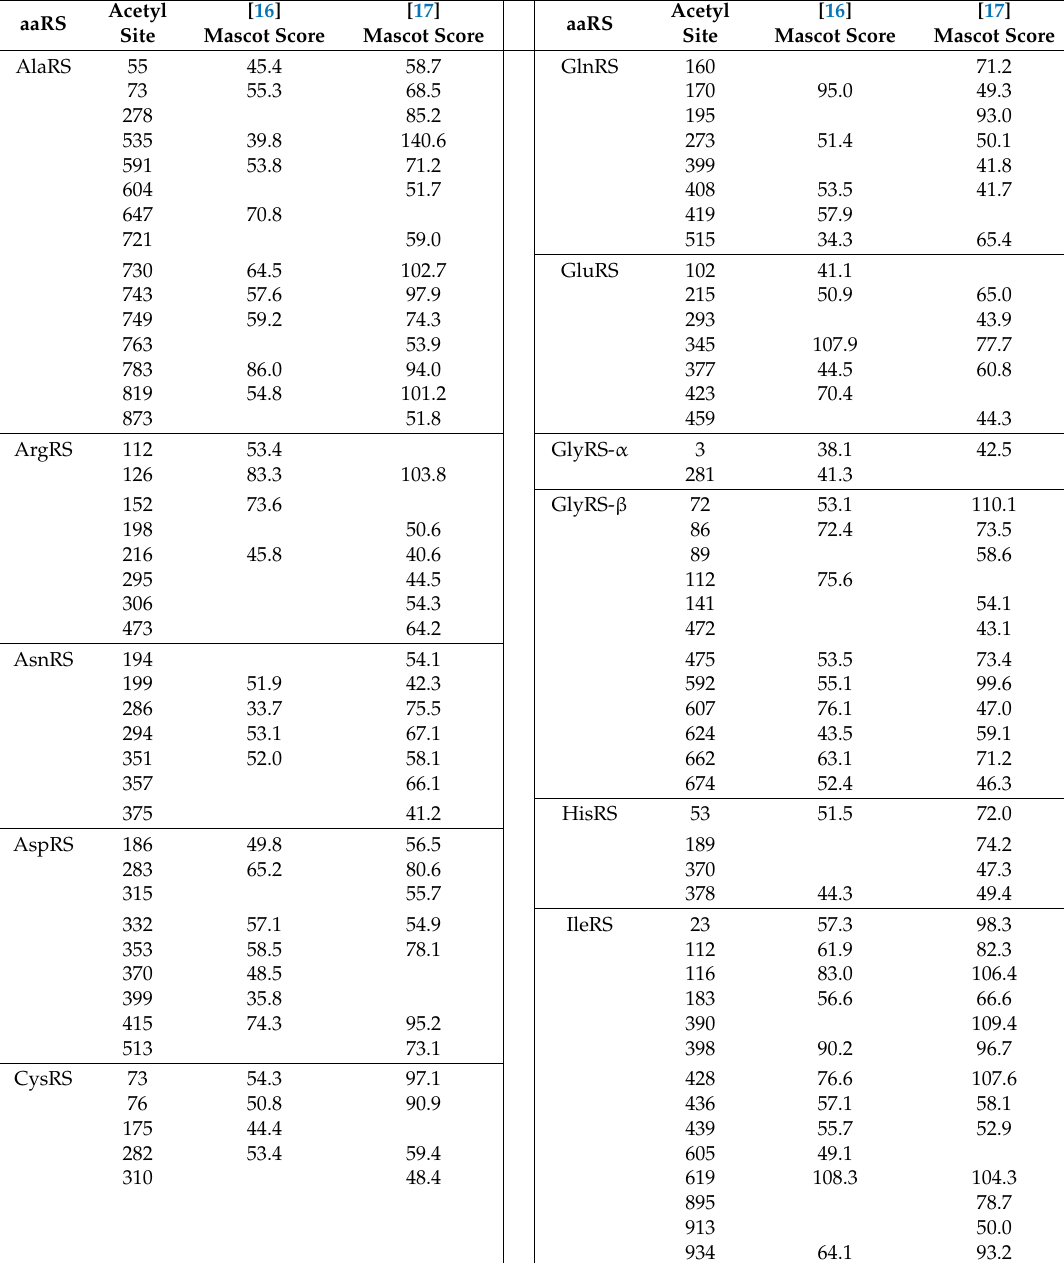
Table A1. Lysine acetylation sites in all aminoacyl-tRNA synthetases (aaRSs) from E. coli . The data was collected from the acetylomes performed by Kuhn et al. [16] and Schilling et al.